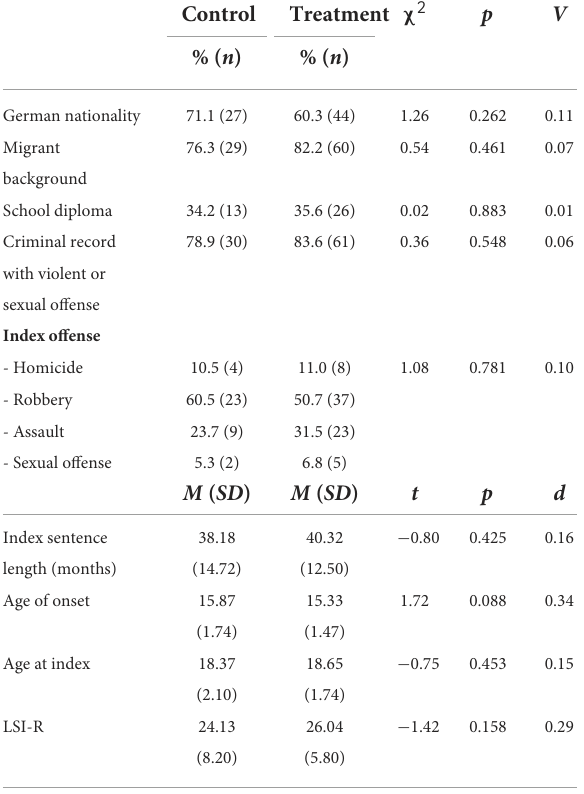
TABLE 1 Pretreatment characteristics of the control ( n = 38) and treatment group ( n =